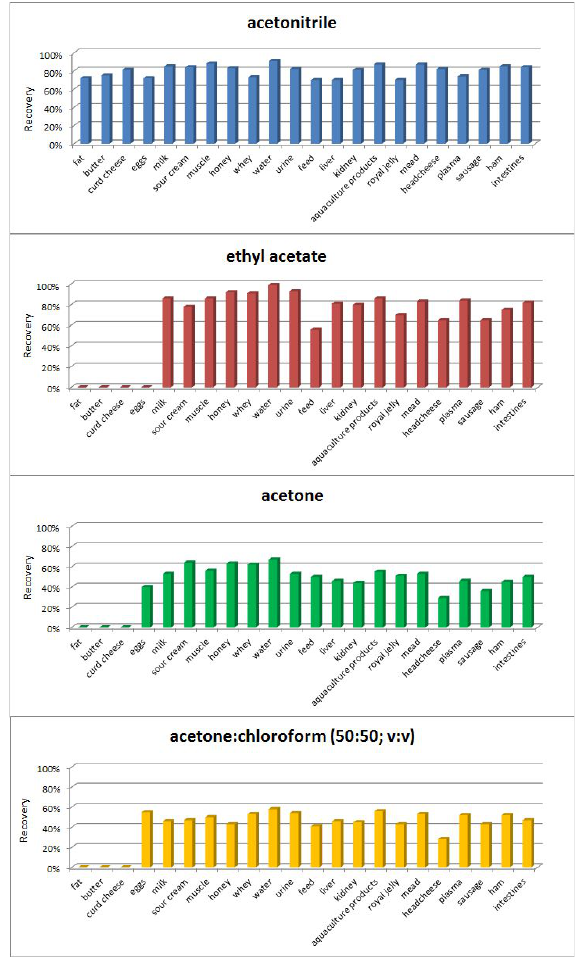
Figure 2. Comparison of suitability of different extraction solvents for